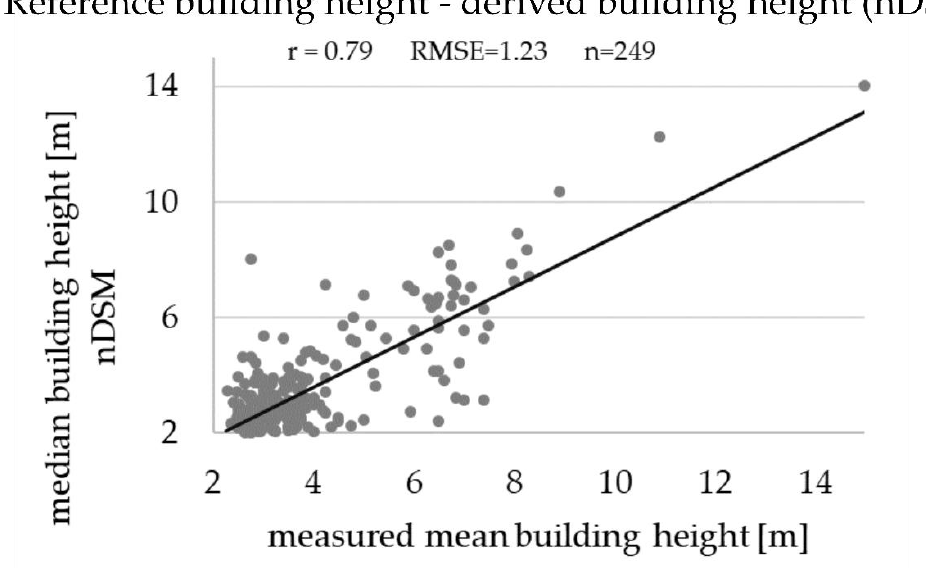
Figure A1. Validation for determined building heights from WV-1 nDSM. The reference dataset was generated by 249 measured buildings. The mean building represents the mean height from wall height and rooftop height.